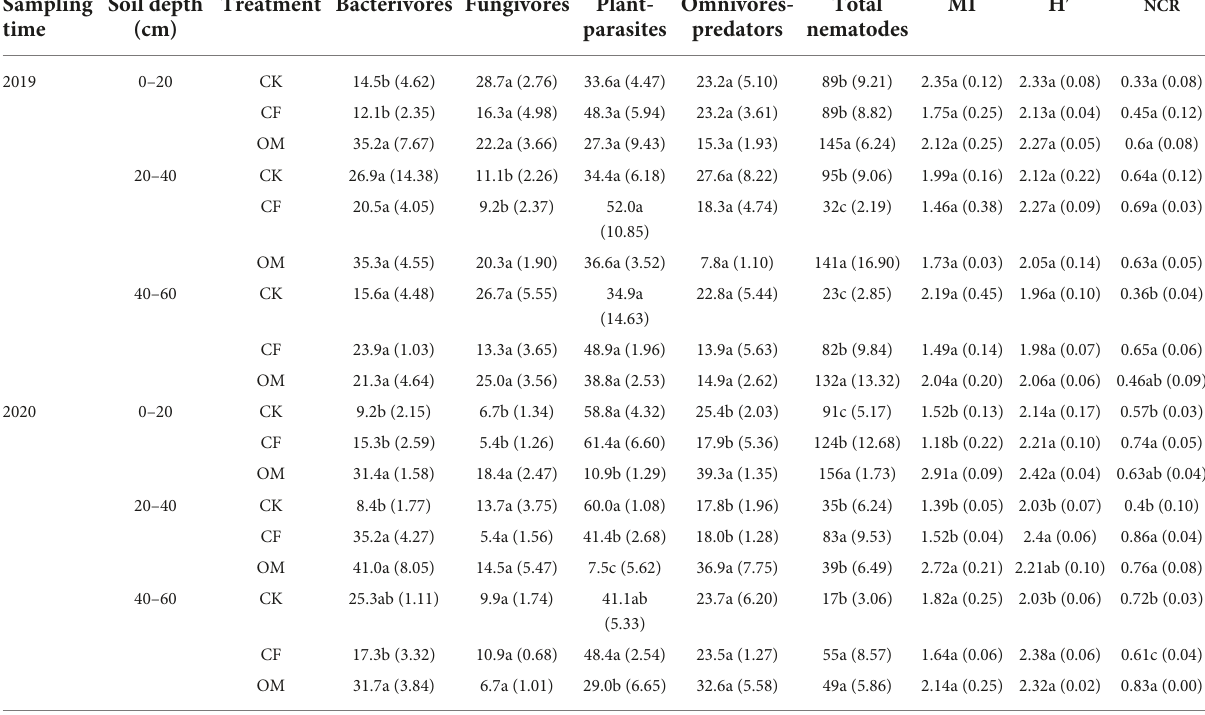
TABLE 2 Effect of organic manure (OM) and chemical fertilization treatments on the relative abundance of trophic groups (%) of nematode and ecology indices in the field experiment. Sampling